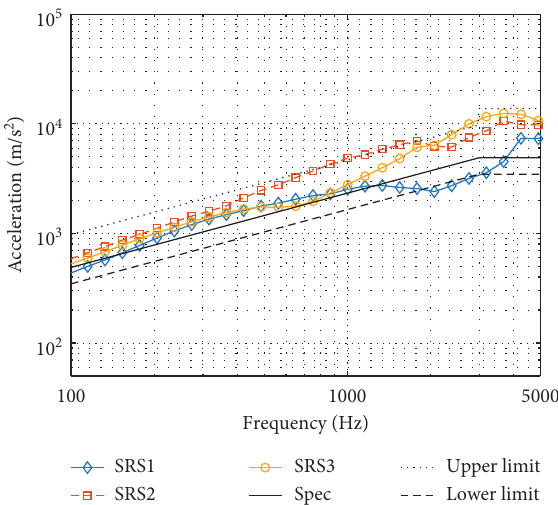
Figure 3: Three SRS measurements within NASA recommended lower and upper